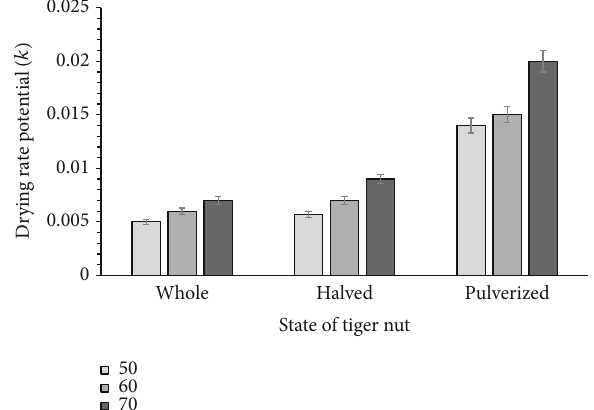
Figure 4: Drying rate constant ( k ) for the Midilli et al. model for the tiger nuts dried at the various